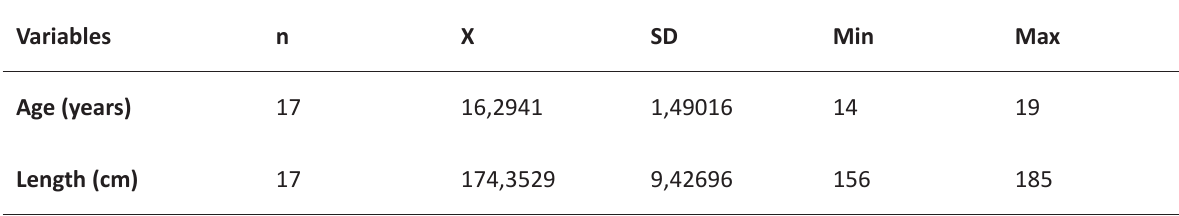
Table 1. Demographic Characteristics of Judiciaries Participating in the Study (Mean ± SD)